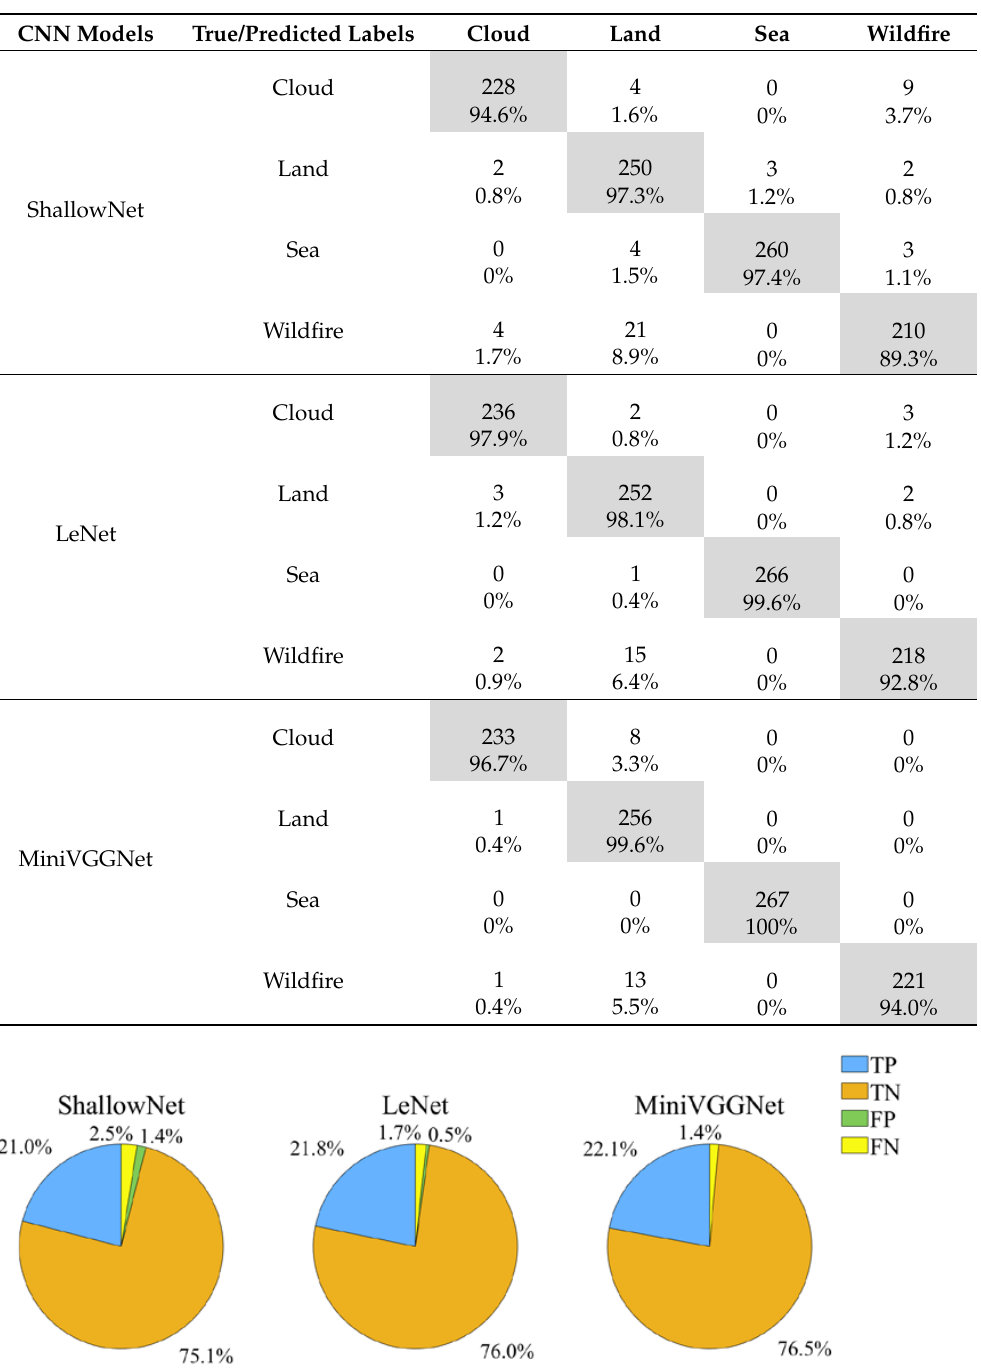
Table 3. Confusion matrix of ShallowNet, LeNet, and MiniVGGNet (gray color means TP value).